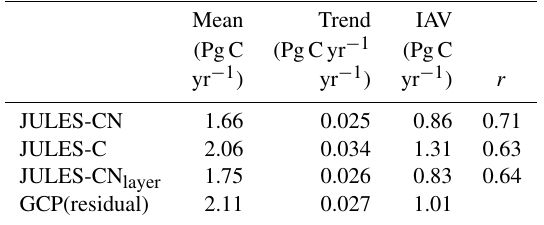
Table 3. Statistics of NEE from JULES-CN, JULES-C, JULES- CN layer , and the GCP observation-based estimates (Friedlingstein et al., 2020), over the period from 1960 to 2009 inclusive. Columns 2–4 respectively show the mean, linear trend, and the interannual variability (IAV; standard deviation) around that trend. Column 5 shows the correlation coefficient between each model NEE time se- ries and the GCP time series. Mean Trend IAV (PgC (PgCyr − 1 (PgC yr − 1 ) yr − 1 ) yr − 1